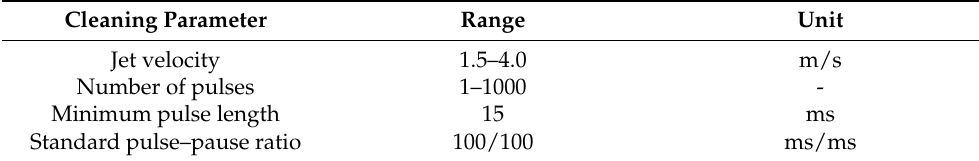
Table 2. Cleaning parameters and the corresponding ranges applicable in the cleaning setup. Cleaning